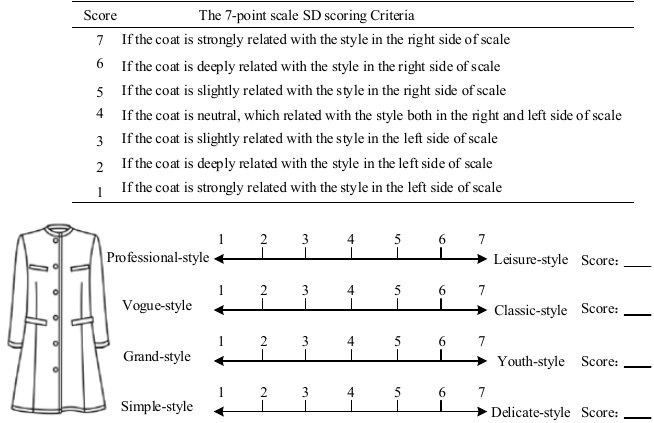
Figure 5. One of the questionnaires.